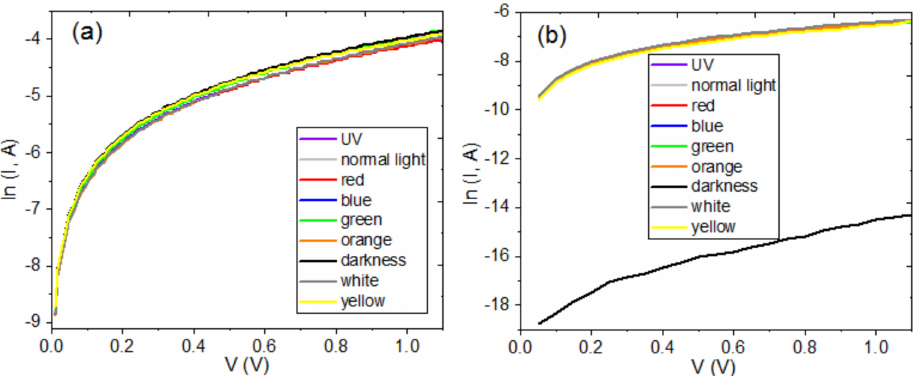
Figure 6. ln I vs. V characteristics for ( a ) ITO/MP/Ag and ( b ) ITO/PEDOT:PSS/Ag devices at different radiation